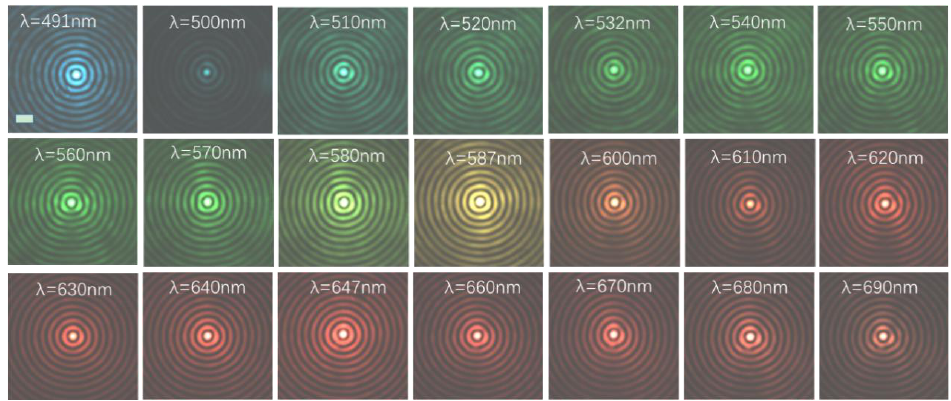
Figure 6. Experimentally measured intensity profiles of Bessel beams generator with wavelength- independent characteristics. NA = 0.7 and design wavelength λ = 587 nm. (Measured intensity profiles at wavelengths λ = 491, 500, 510, 520, 532, 540, 550, 560, 570, 580, 587, 600, 610, 620, 630, 640, 647, 660, 670, 680, and 690 nm) . Scale bar: 1 μm.